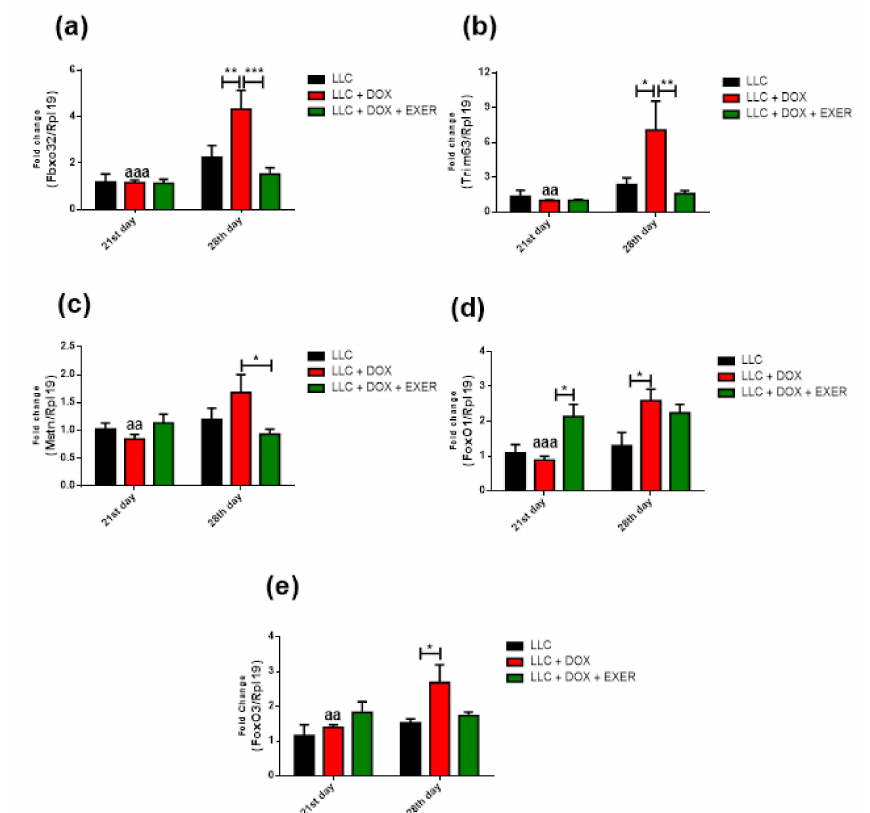
Figure 3. Gene expression of proteins involved in the activation of muscle catabolism. In gastrocnemius muscle, treatment with doxorubicin stimulated the atrophic pathways, while the combination with resistance exercise prevented this e ff ect. ( a ) Fbxo32 gene expression; ( b ) Trim63 gene expression; ( c ) myostatin gene expression; ( d ) FoxO1 gene expression; ( e ) FoxO3 gene expression. Values represent the mean and standard error of the mean of the analysis of the data obtained n = 5–6. * p < 0.05; ** p < 0.01; *** p < 0.001; aa: p < 0.01 compared with the respective group on the 28th day. aaa: p < 0.001 compared with the respective group on the 28th day. LLC = Lewis lung carcinoma; DOX = doxorubicin; EXER = endurance